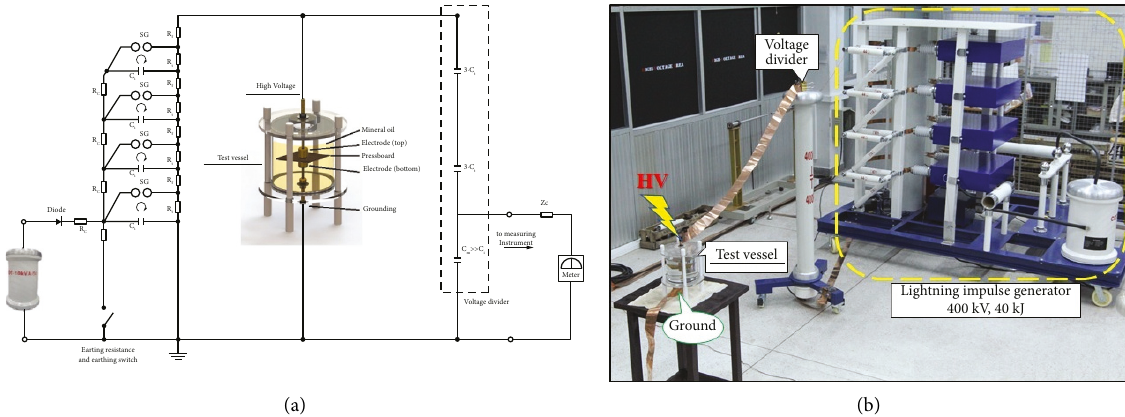
Figure 6: Test circuits for measuring lightning impulse breakdown voltage strengths. (a) Equivalent circuit for measuring lightning impulse breakdown strengths. (b) Test circuit preparation.